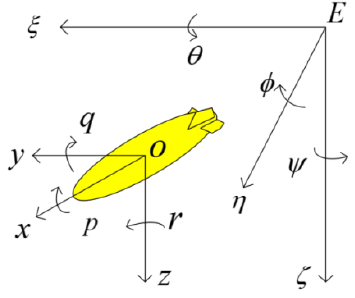
Figure 1. AUV coordinate diagram.